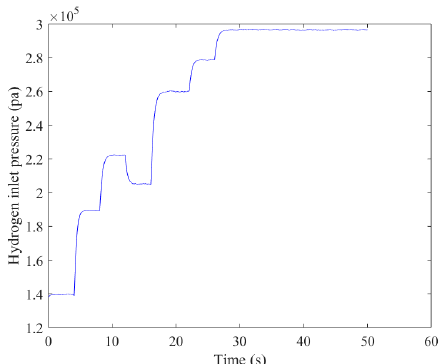
Figure 9. Hydrogen inlet pressure changes with time.